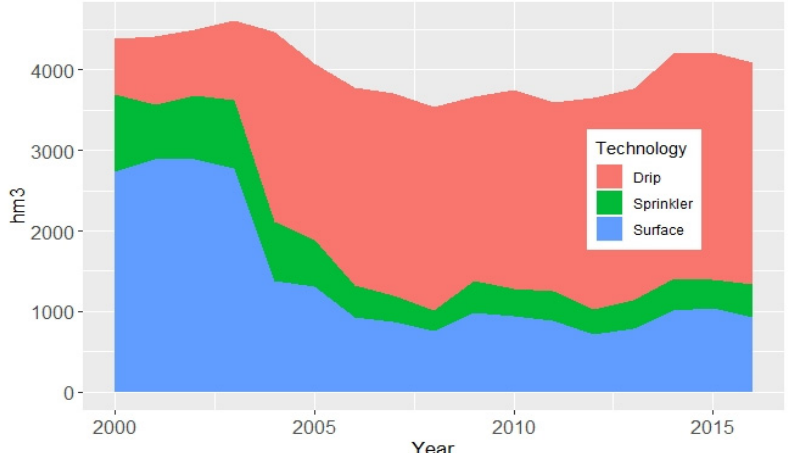
Figure 1. Water use by type of irrigation technology in Andalusia. Source: INE [53].